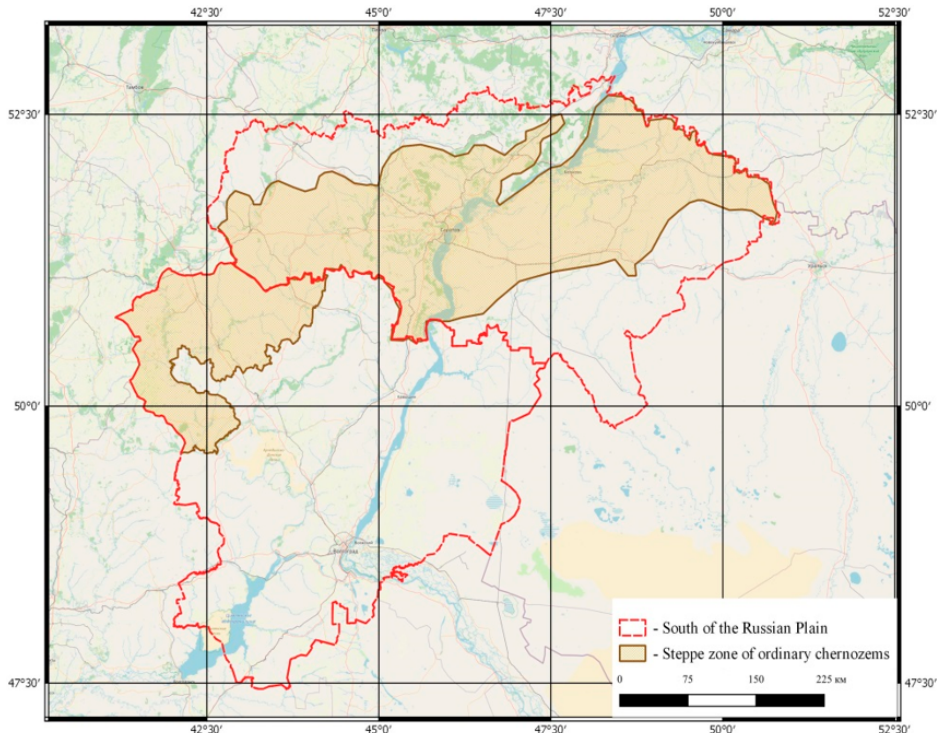
Figure 1. Geographical location of the steppe zone of ordinary chernozems.